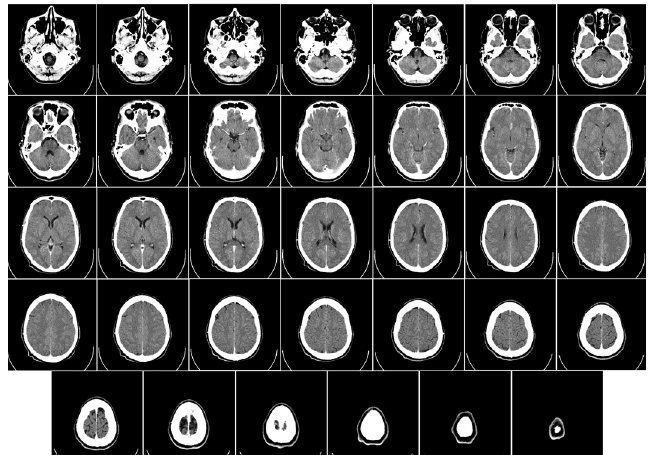
Fig. 8 TC Images.